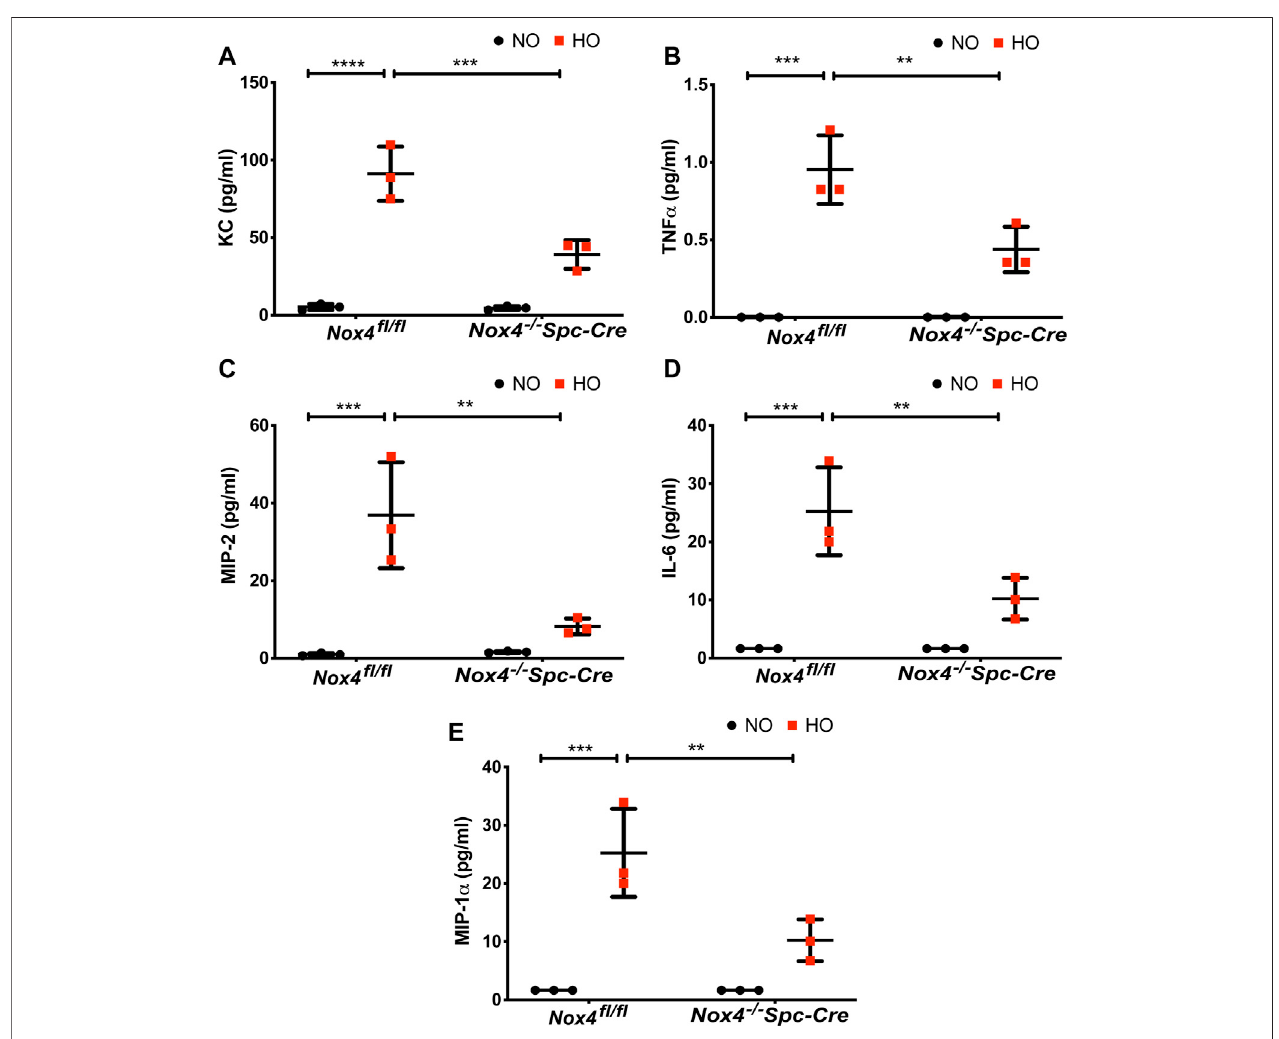
FIGURE4| Nox4 deletion in AT2cells ofmice reduced in fl ammatorycytokine pro fi le. Nox4 fl / fl control mice and Nox4 − / − Spc-Cre mice weresubjected toNOor HO for66 h.TheBAL fl uidcollectedweresubjectedtomultiplexassaystodetermine thecytokinepro fi les. (A) KC, (B) TNF- ∝ , (C) MIP-2, (D) IL-6and (E) MIP-1 ∝ showed a signi fi cant elevation in the BAL fl uid of control HO group which were attenuated by epithelial deletion of Nox4 , expressed as pg/ml. n = 3. **** p < 0.0001, *** p < 0.001 and ** p <